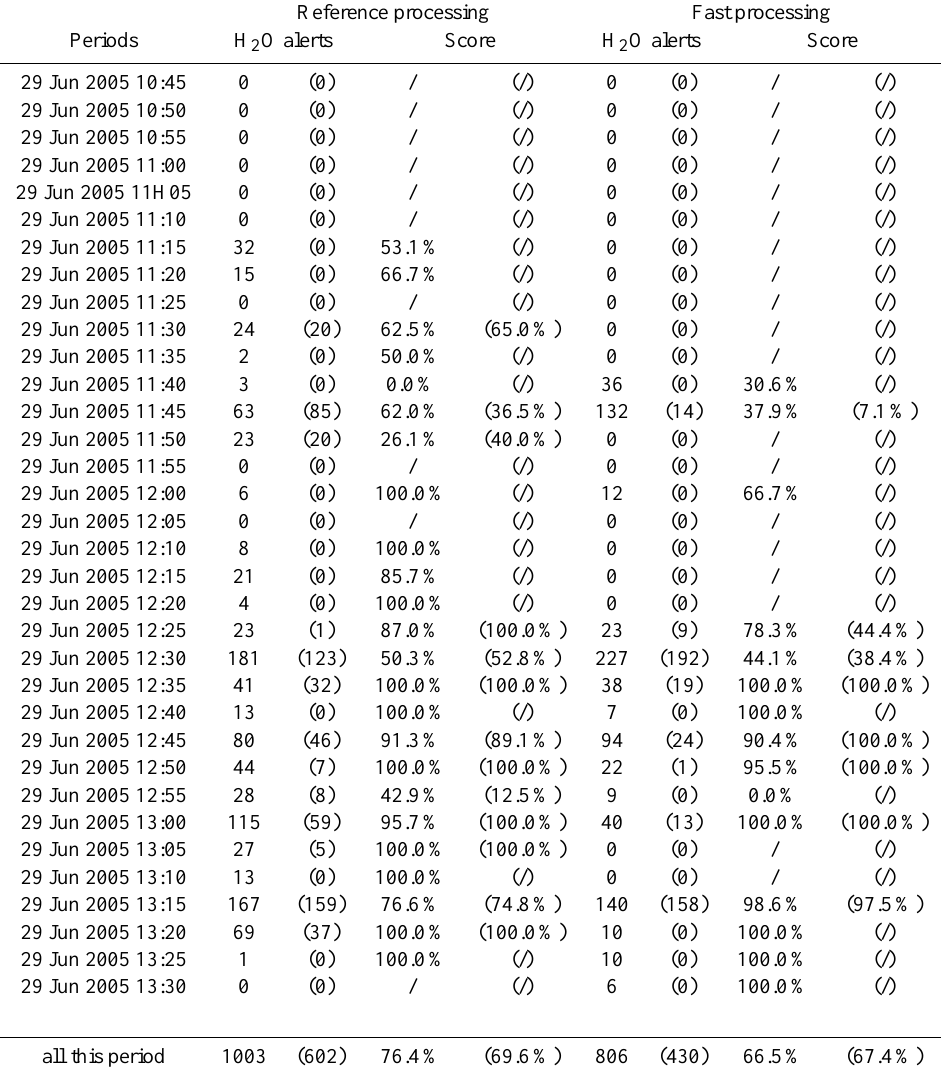
Table 4. Statistical results (i.e. number of alerts and final scores) between 10:45 and 13:30UTC on 29 June 2005. The time resolution of GNSS observations is 5min (post-processing and operational runs). The statistical results obtained without the use of pseudo-ZTD established from gradients are presented in